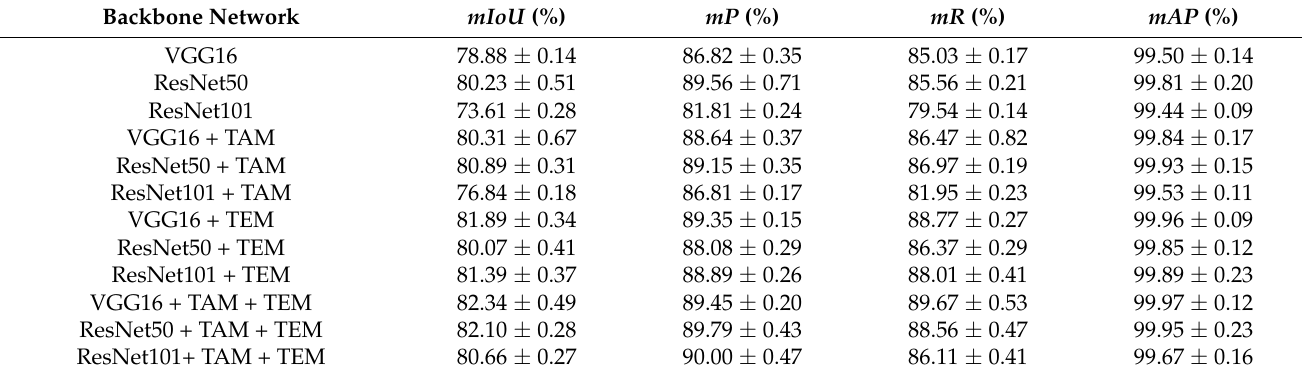
Table 2. Results of texture attention module and texture enhancement module ablation